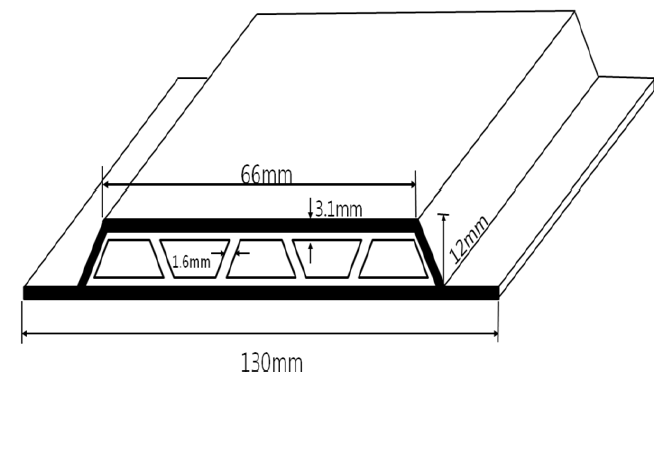
Figure 1. Glass fiber reinforced plastic (GFRP) composite